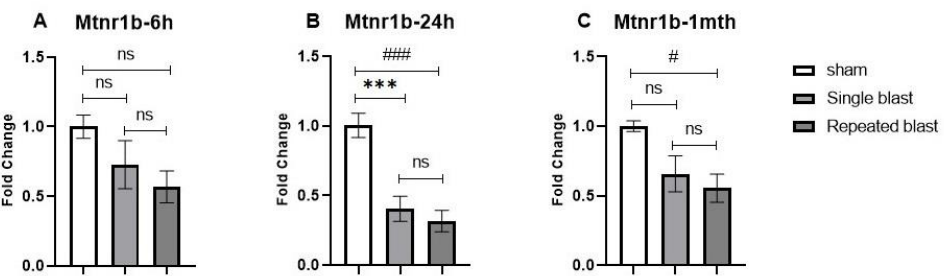
Figure 6. Effect of single and repeated blast exposure on Mtnr1b mRNA levels at night in the pineal glands of SD rats at ( A ) 6 h, ( B ) 24 h, and ( C ) 1 month after blast injury. Results are expressed as means ± SEM (n = 6); *** p < 0.001, for sham vs. single blast group; ### p < 0.001, and # p < 0.05 for sham vs. repeated blast group; ns — not significant.